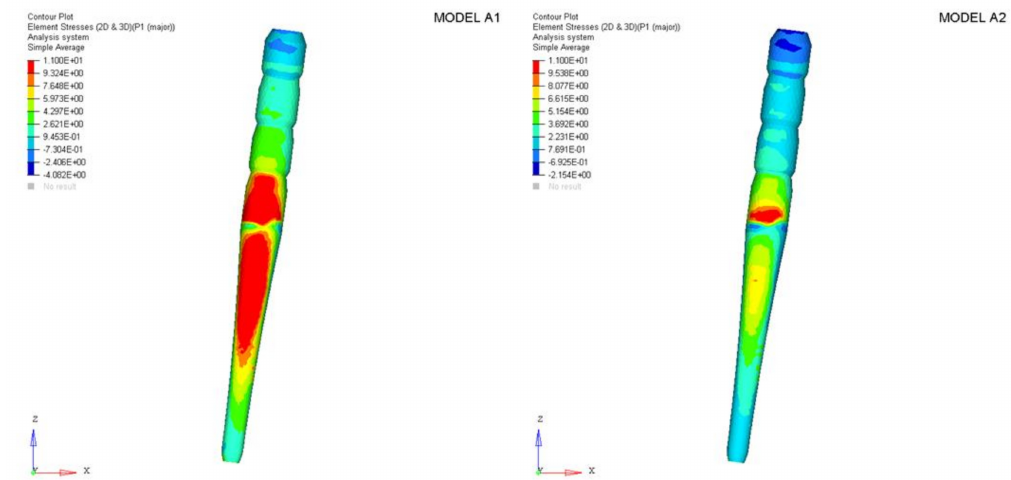
Figure 8. Models A1 and A2: Maximum principal stress distribution at the interface between the post and surrounding structures from the coronal to the apical part. The color scale was chosen to allow for comparison among the analyzed